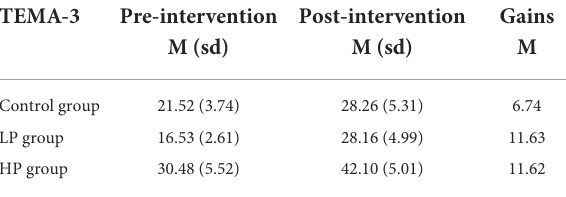
TABLE 4 Descriptive statistics of domain-specific predictors (symbolic and non-symbolic comparison assessed in both assessment phases by